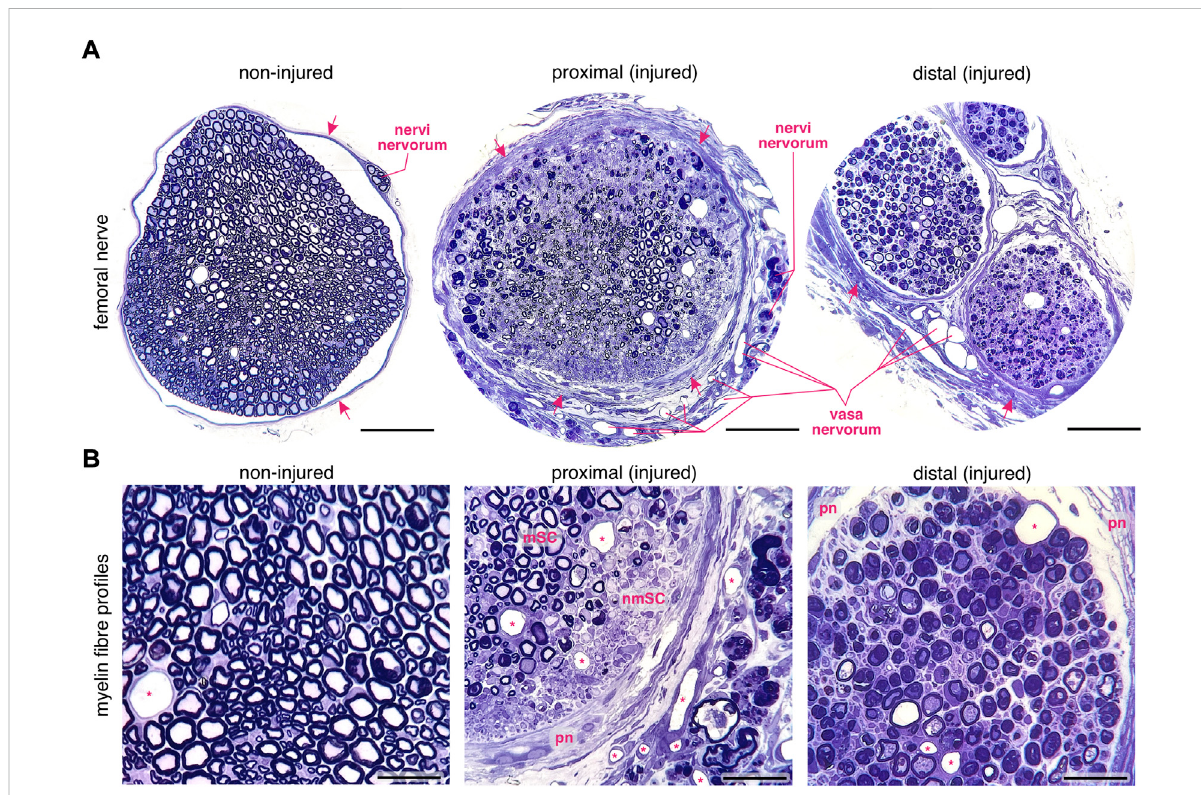
FIGURE 1 Changes in myelin fi bre pro fi les of the regenerating murine femoral nerve after transection. (A) Left: a transversal pro fi le of an intact femoral nerve. Arrows indicate the perineural sheath. Middle: a transversal pro fi le of the proximal stump of the regenerating femoral nerve. Note the thick perineurium(arrows),theenhancedangiogenesisandthedegenerationof nervinervorum aftertransection.Right:thedistalstumpofthetransected femoralnerve.Scalebar,100 µm. (B) Left:theintactfemoralnerveiscomposedofhomogeneouslydistributedmyelinatedandnon – myelinated fi bres. Middle: sprouting in myelinated (myelinating Schwann cells, mSC) and non – myelinated (non – myelinating Schwann cells, nmSC) areas in the regeneratingproximal nervestump. Thethickperineurium(pn)andnewly formedbloodvessels (asterisks) are visible. Right:distally to thelesionsite, myelindecompositionoccursinvariableformswithintheSchwann cells.Scalebar, 30 µm.Staining: toluidineblue.Specimen:75 – nm – thinsections of resin – embedded non-injured nerves versus injured nerves 10 days after transection in C57Bl6/J